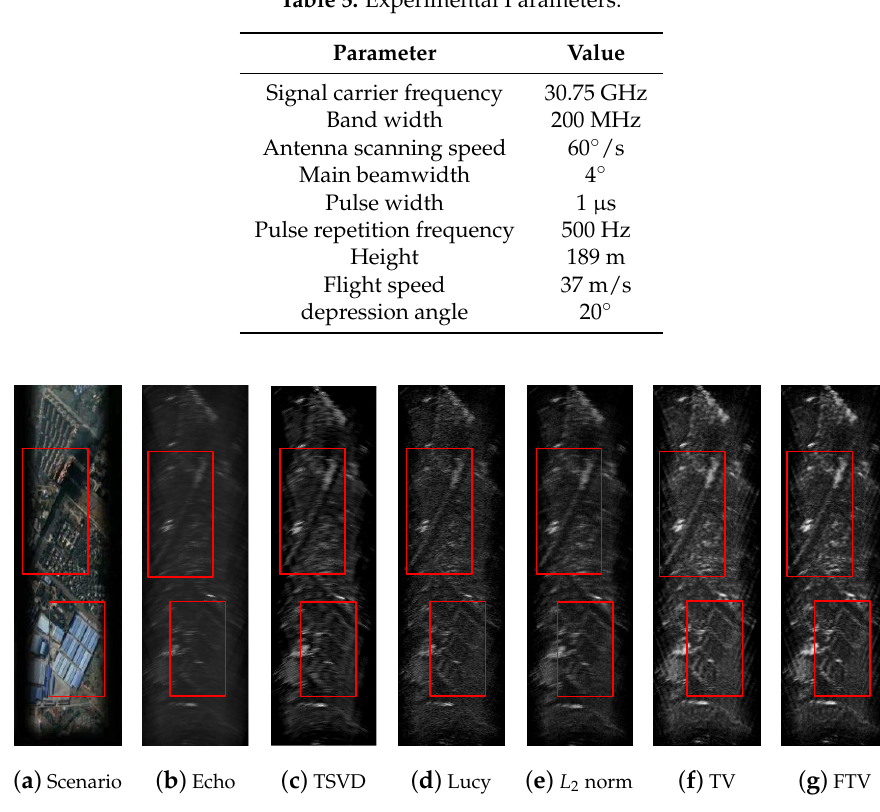
Figure 7. The experimental data result. ( a ) Optical scenario; ( b ) Echo image; ( c ) The TSVD method result; ( d ) The Lucy-Richardson method result; ( e ) The L 2 norm regularization method result; ( f ) The TV method result; ( g ) The proposed FTV method